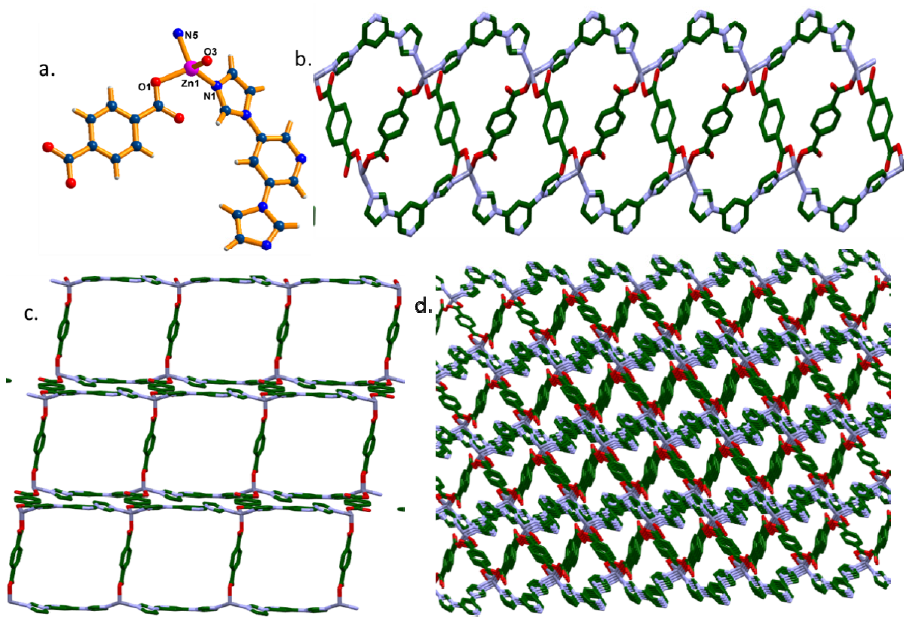
Figure 3. Schematic representations of the crystal structure of 3 . ( a ) The coordination environment of the Zn(II) ions. ( b ) Zigzag chains in 3 . ( c ) Double pillaring of 3 chains with dip resulting in the formation of the 2D network of 3 . ( d ) Densely packed bilayers in 3 along the b ‐ axis.